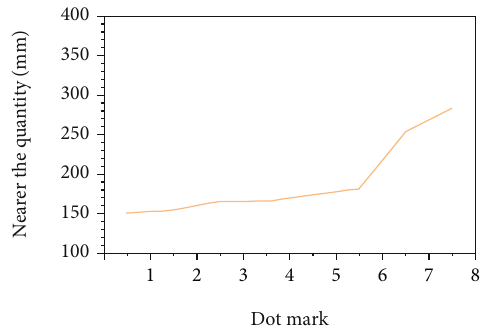
Figure 5: Moving quantity of two sides of auxiliary transportation.